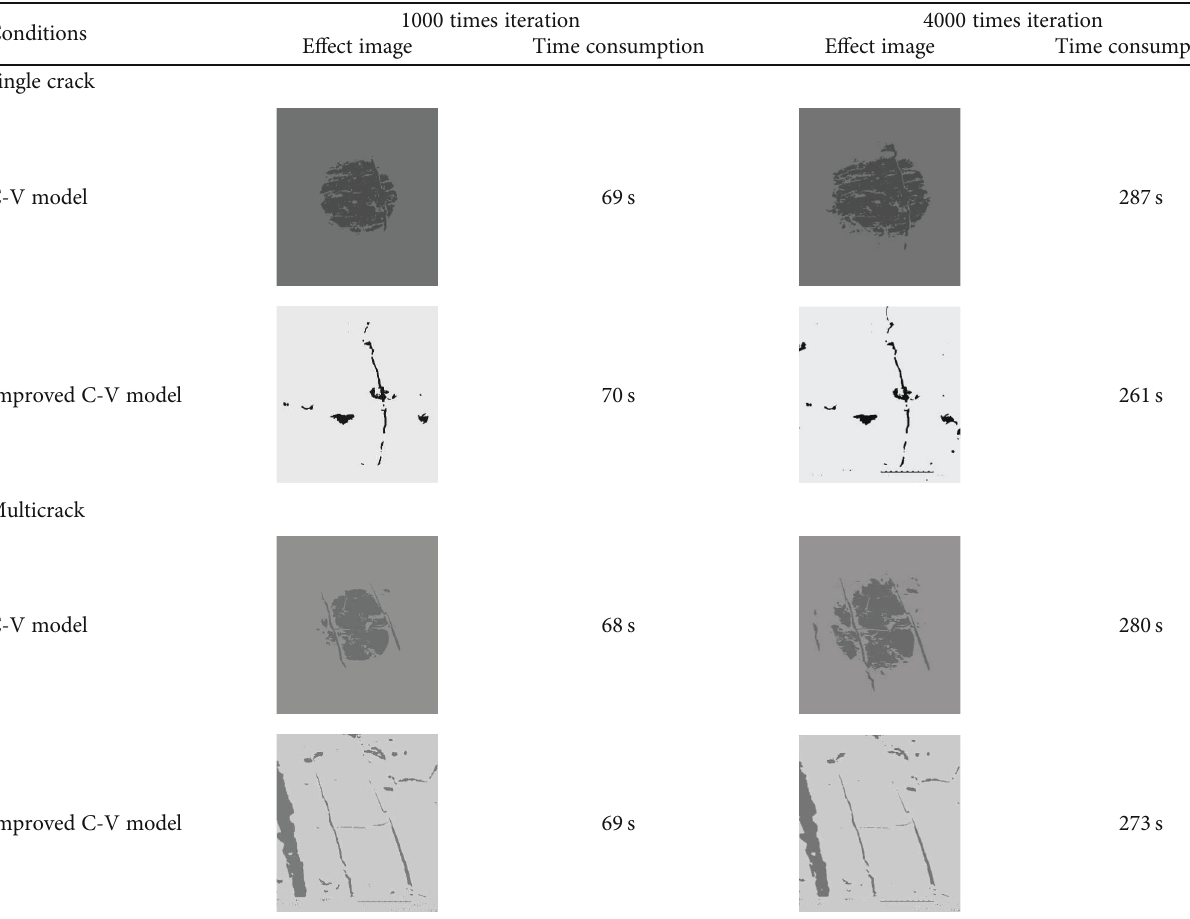
Table 1: Comparison between the e ff ects of the C-V model and the improved C-V